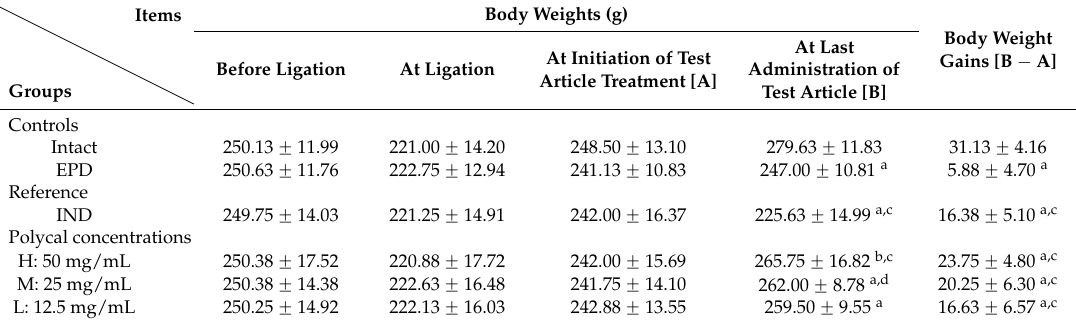
Table 1. Body weight gains after 10 days of continuous treatment in Intact or EPD